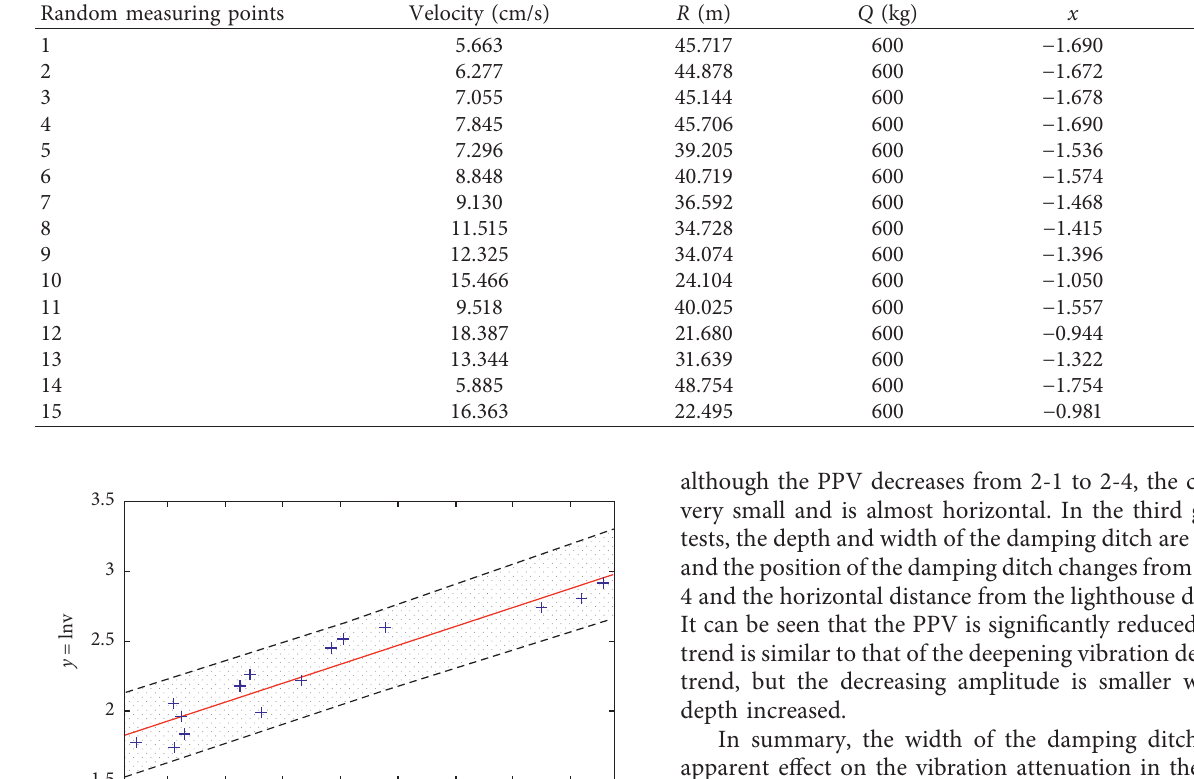
Table 7: Calculated values of the Sadove transformation equation for the No. 0 model. Random measuring points